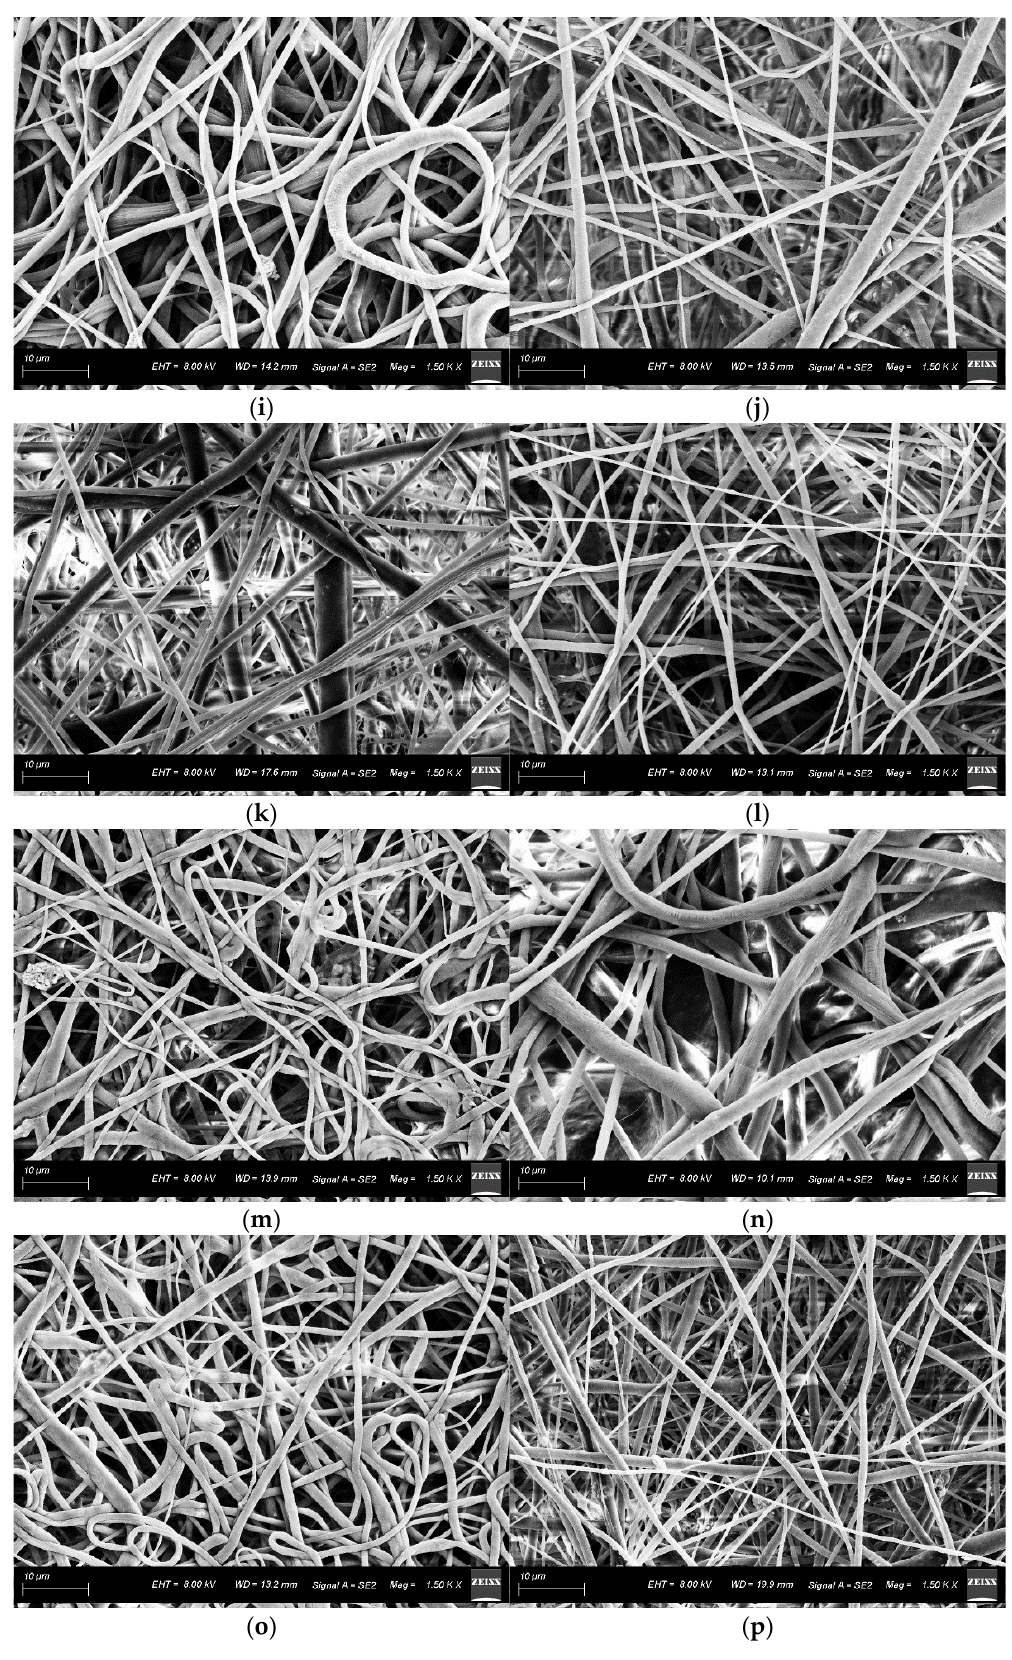
Figure 1. SEM micrographs of 16 specimens ( a – p ) prepared for Taguchi orthogonal array analysis. All the SEM micrographs were collected at 1500× magnification and at an accelerating voltage of 8 kV.